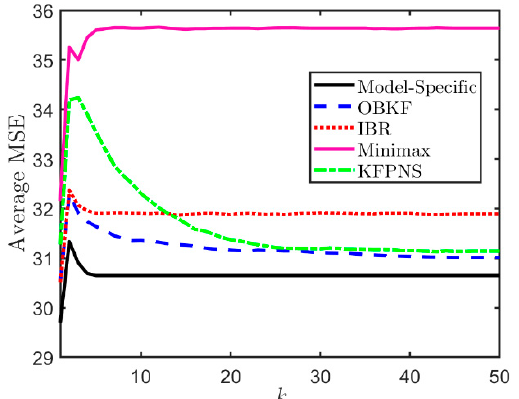
Figure 3. Average MSE of various filters when α